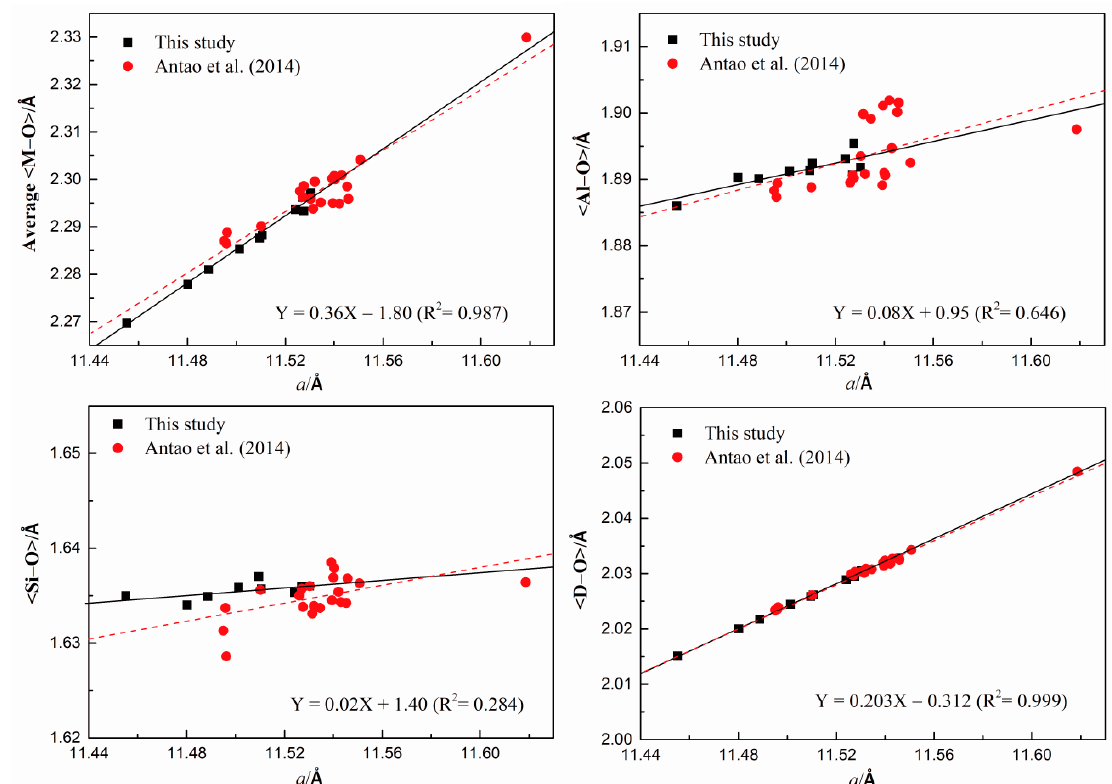
Figure 6. Structural variations across the Alm-Pyr solid solution series. Black square represents data and solid trend lines (black) are the linear fit to data from this study and their equations are given as inserts. Red circle represents data and dashed trend lines (red) are the linear fit to data from the reference of Antao et al. (2014) [24].